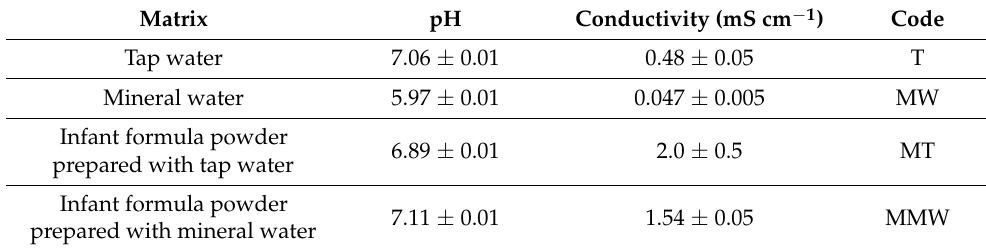
Table 1. Matrices characteristics.